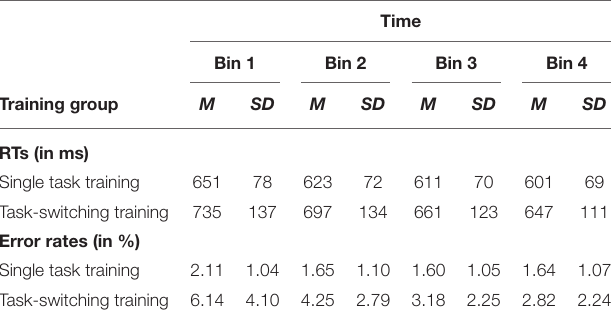
TABLE 3 | Means (M) and standard deviations (SD) for RTs (ms) and error rates (%) as a function of training group (single task training, task-switching training) and time (bin 1, bin 2, bin 3, bin